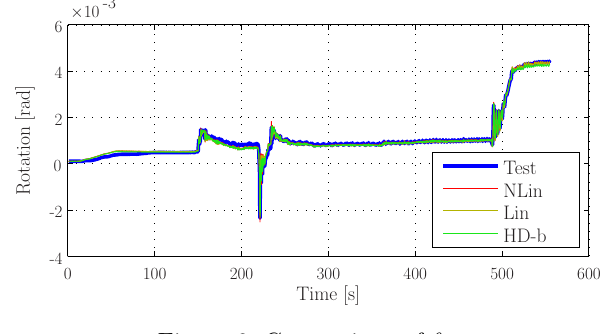
Figure 9: Comparison of θ x